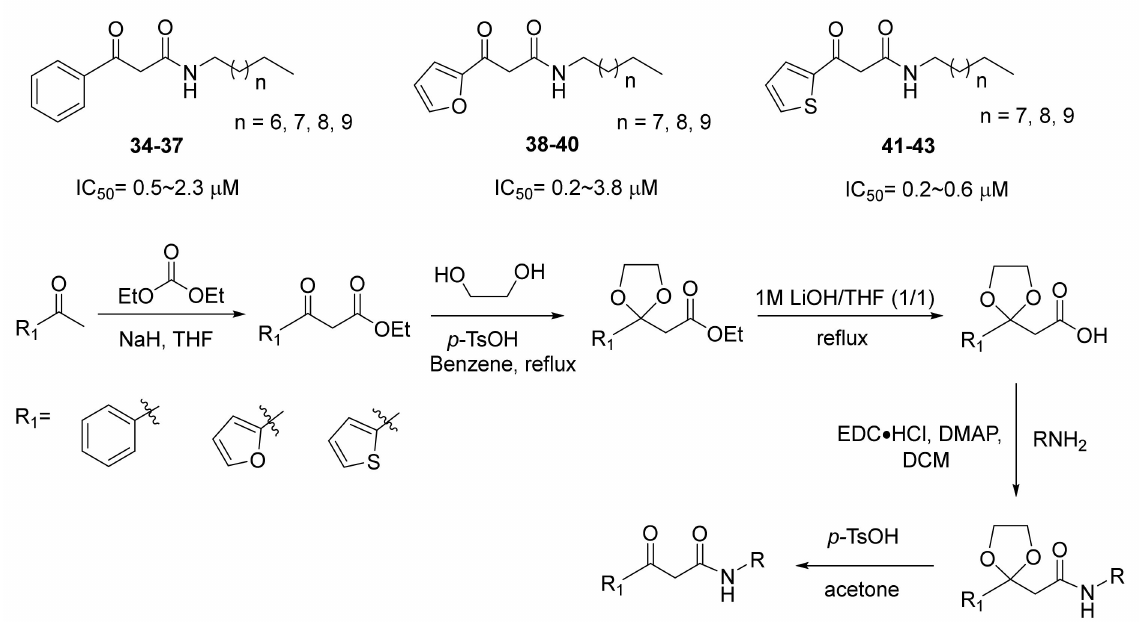
Scheme 6. Furan and thiophene-containing LasR QS antagonists.